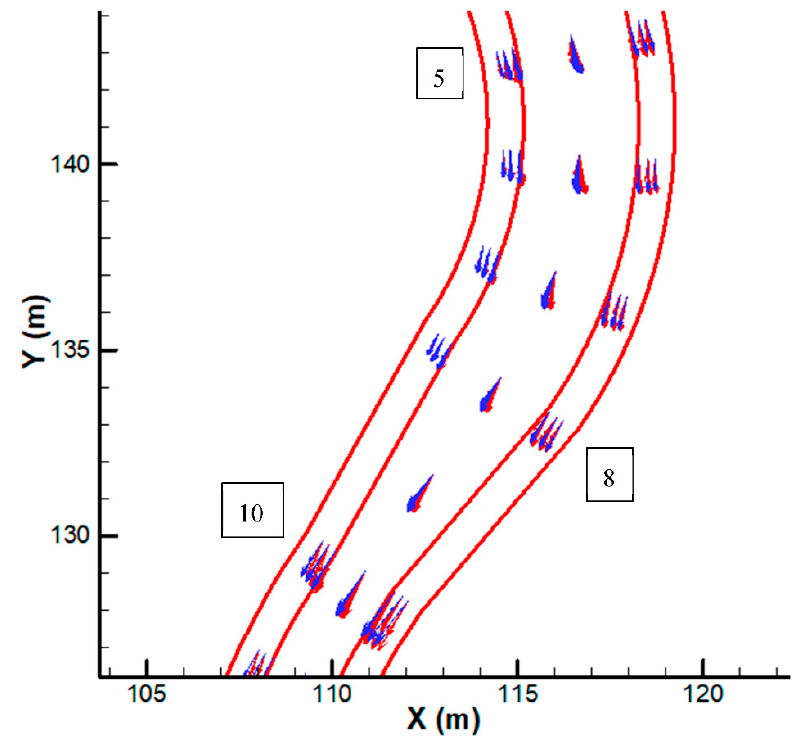
Figure A9. Plan-view comparison of simulated (blue) and measured (red) velocity vectors for the upstream channel curve.